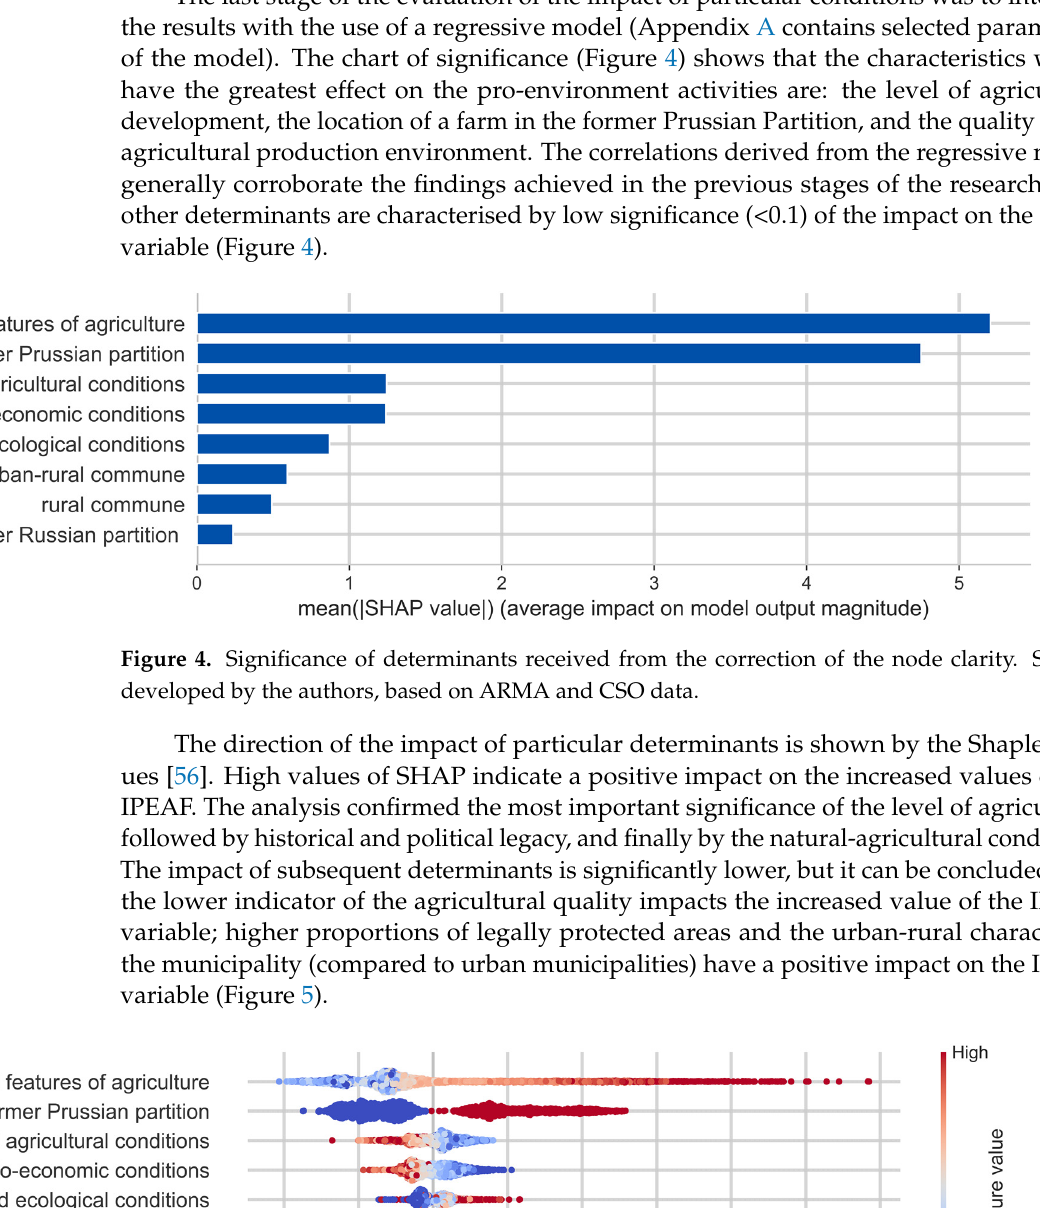
Figure 6. Shapley values for the agriculture development variable. Source: developed by the au- thors, based on ARMA and CSO data. The quality of the production environment in agriculture has a polynomial impact on the IPEAF variable. A low value of the natural conditions for agriculture has a neutral impact on the pro-environment activity of farmers. The analysis demonstrated that to- gether with the increase in the WjRpp, the impact on the IPEAF variable becomes increas- ingly negative. In addition, the municipalities which were not in the Prussian Partition show a neutral impact on the activity of farmers running farms where the quality of the agricultural environment is the highest. The high correlations are still much weaker than obtained for the agricultural development level, as the SHAP values are in a narrower range (Figure 7). A low level of socio-economic development of municipalities has a positive impact on the pro-environmental activity of agricultural farms. Along with the growth of the level of development, the impact on the IPEAF variable drops; the level of development of mu- nicipalities has a negative impact when this level is high (Figure 8).